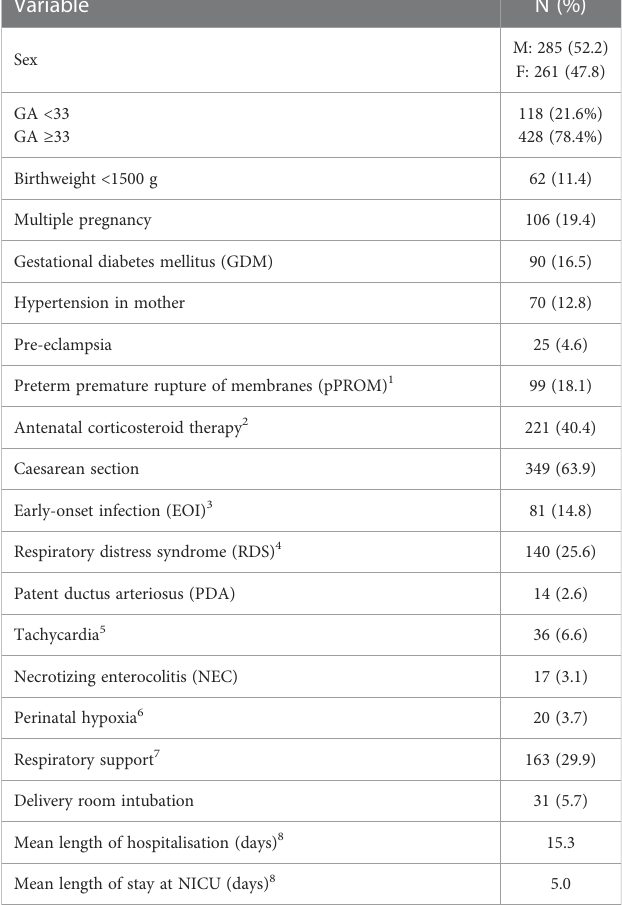
TABLE 1 Clinical data of preterm neonates included into the study (n=546).